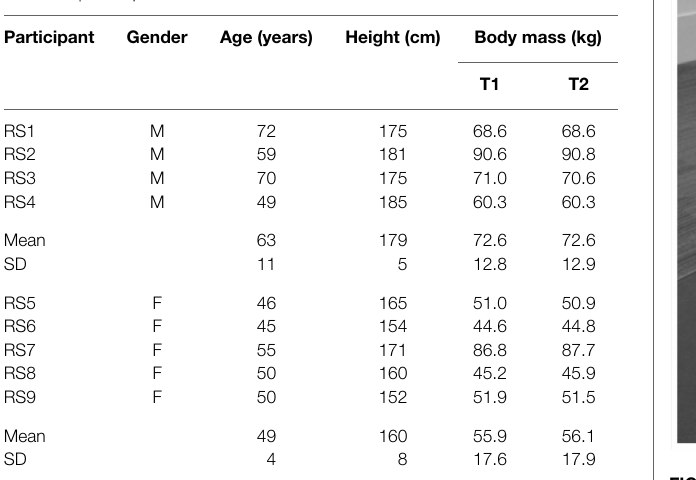
FIGURE 1 | The staircase employed for stair ascent in this